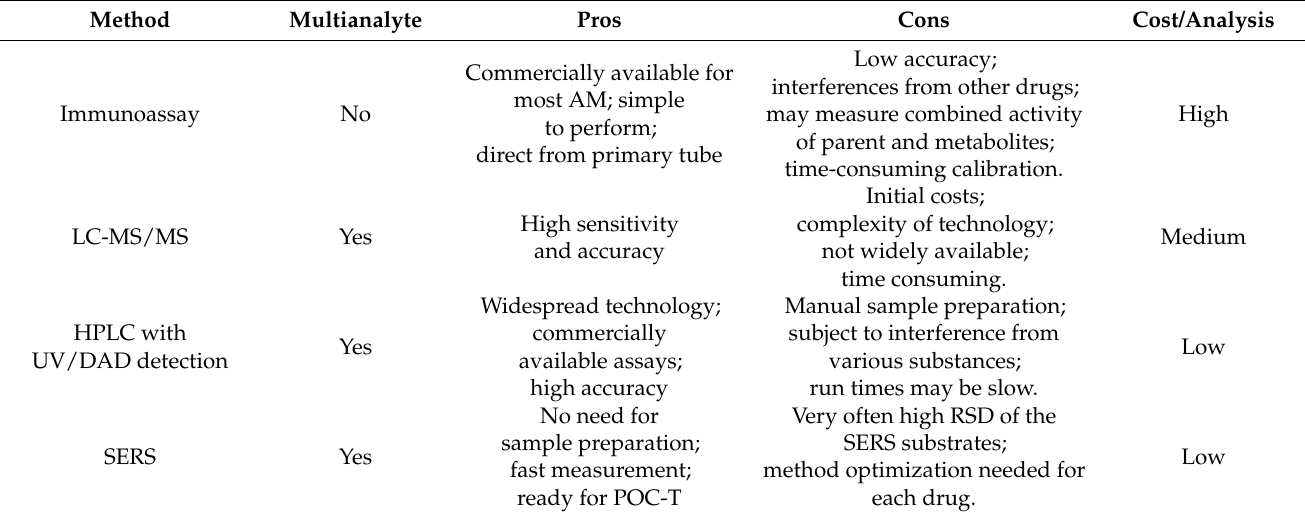
Table 1. Comparison of different technologies for determining antimicrobials levels in